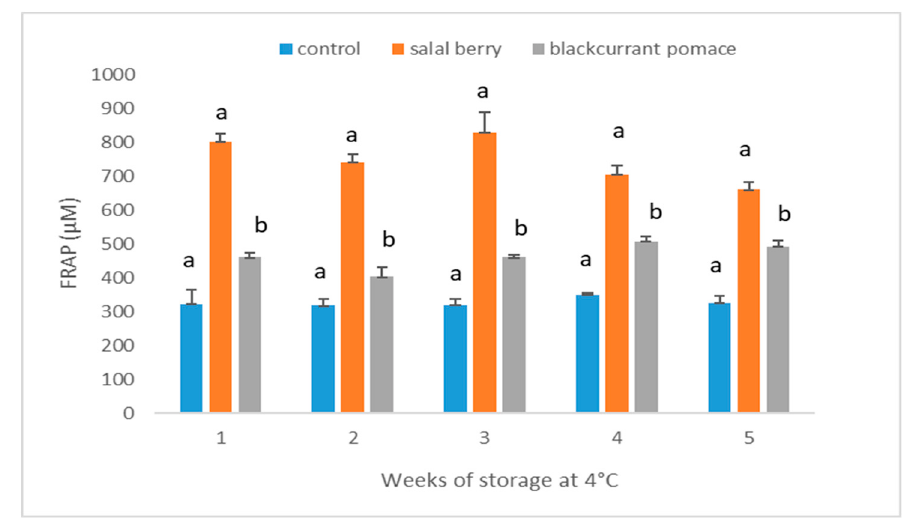
Figure 6. FRAP (ferric reducing antioxidant power) assay of different yogurt beverages. Results are presented as means ± SD. Different low case letters denote significant differences at each time point ( p < 0.05).